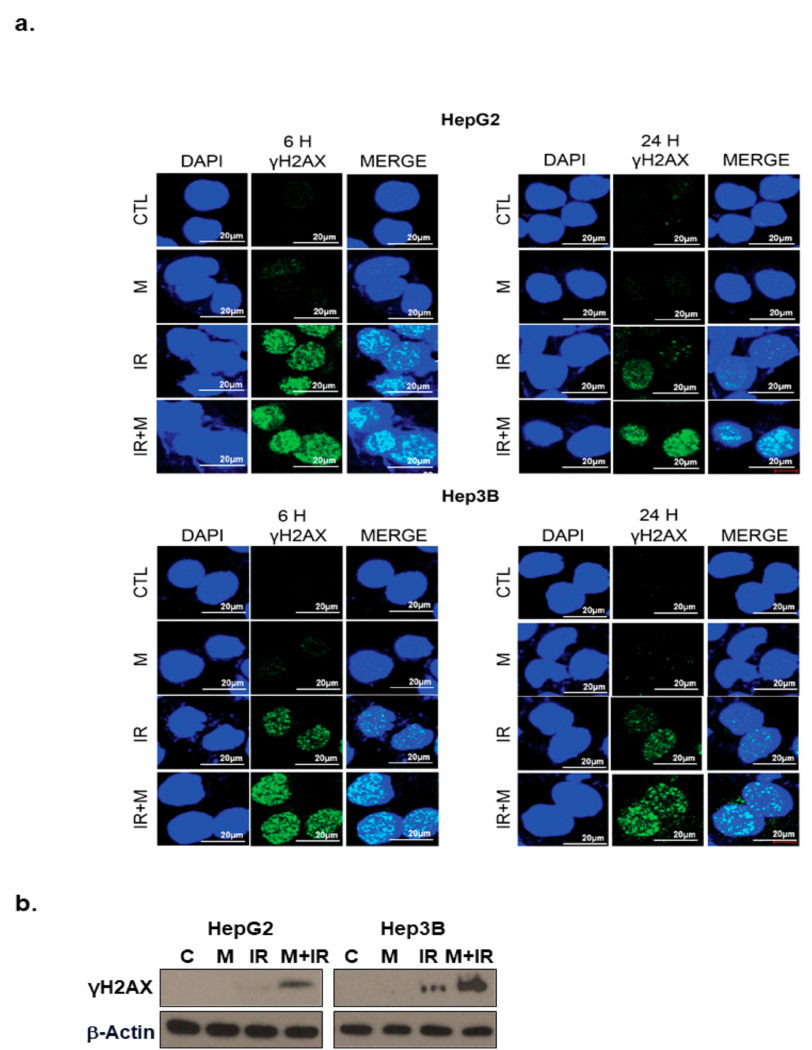
Figure 4. E ff ects of mesima on the DNA damage response in irradiated HCC cells. ( a ) Immunocytochemistry for phosphorylated H2AX, a marker of the DNA damage response, in HCC cells treated to radiation in the presence of mesima at 6 and 24 h after irradiation. ( b ) Immunoblotting of cell lysates with the indicated antibodies. CTL: